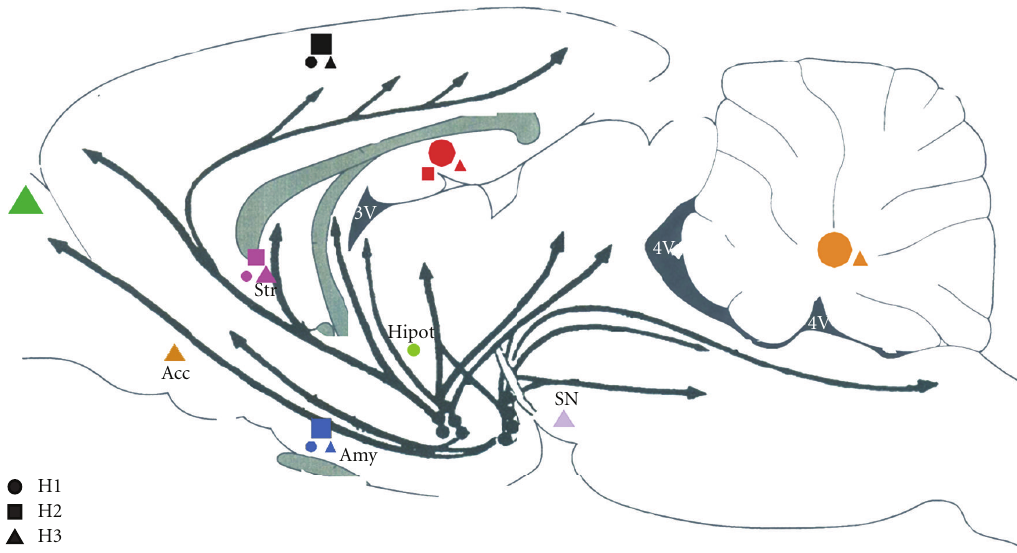
Figure 1: Main histaminergic projections and histamine receptor distribution in the rat brain. The shapes mark the main sites where each receptor subtype is located. In areas that have more than one receptor subtype, the shape with the biggest size indicates which is predominant. Acc: nucleus accumbens; Amy: amygdala, Hipot: hypothalamus, Str: striatum, SN: substantia nigra.